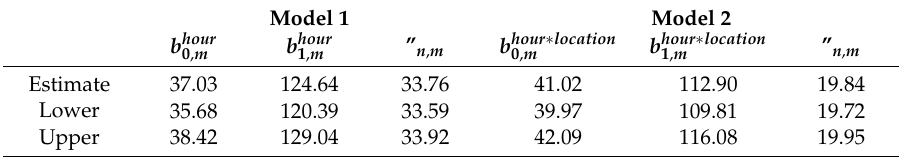
Table 5. Standard deviations of normal distribution for the random-effects terms in the two